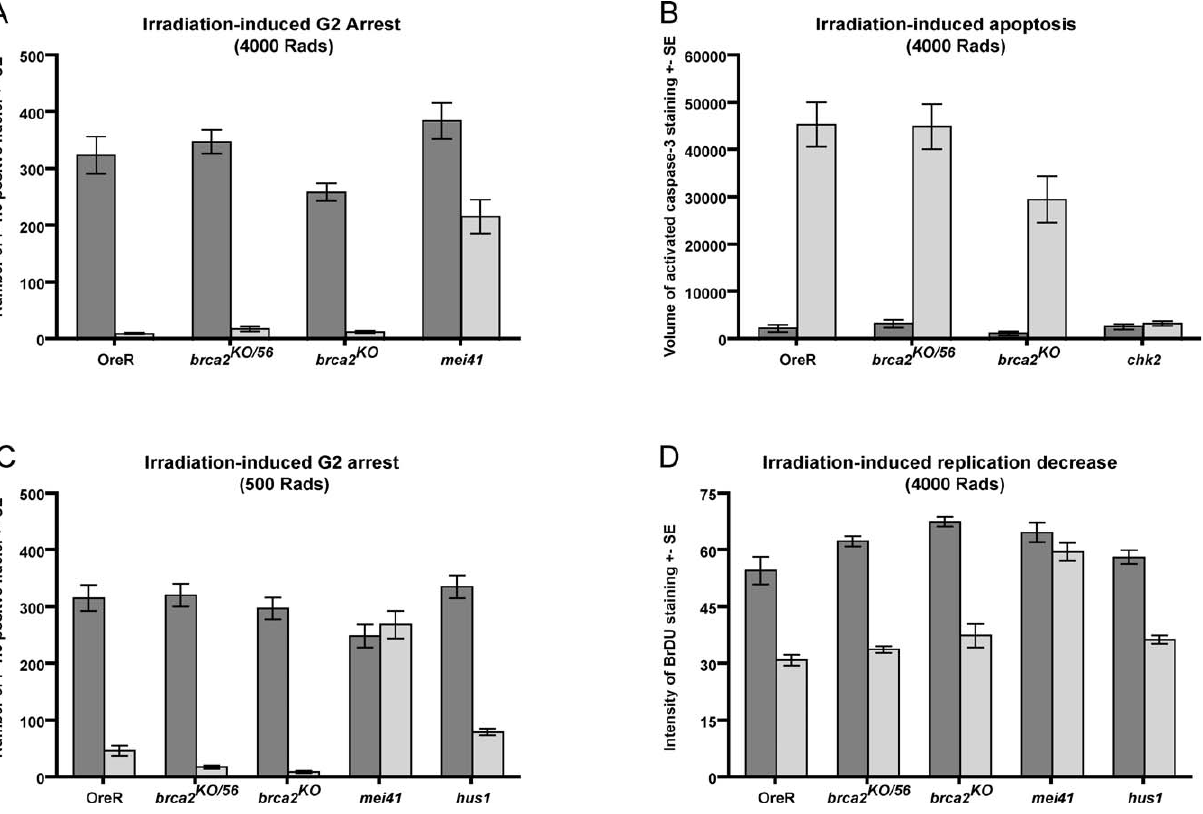
Figure 4. brca2 Is Not Required for the Checkpoints That Respond to Irradiation Damage Climbing third instar larvae were irradiated and then dissected prior to fixation. Error bars represent the standard error from a total of 6–10 samples from 2–3 separate experiments. Representative images can be found in Figure S1. (A) Larvae were fixed 1 hour after a 4,000 Rad IR exposure and stained for the mitotic marker phospho-histone H3. n ¼ 6. (B) Larvae were fixed 4 hours after a 4,000 Rad IR exposure and stained for activated Caspase-3. n ¼ 6. (C) Larvae were fixed 1 hour after a 500 Rad IR exposure and stained for the mitotic marker phospho-histone H3. n ¼ 11. (D) Larvae were inverted 1.5 hours after a 4,000 Rad IR exposure and incubated in Schneider’s media with BrdU for 30 minutes. n ¼